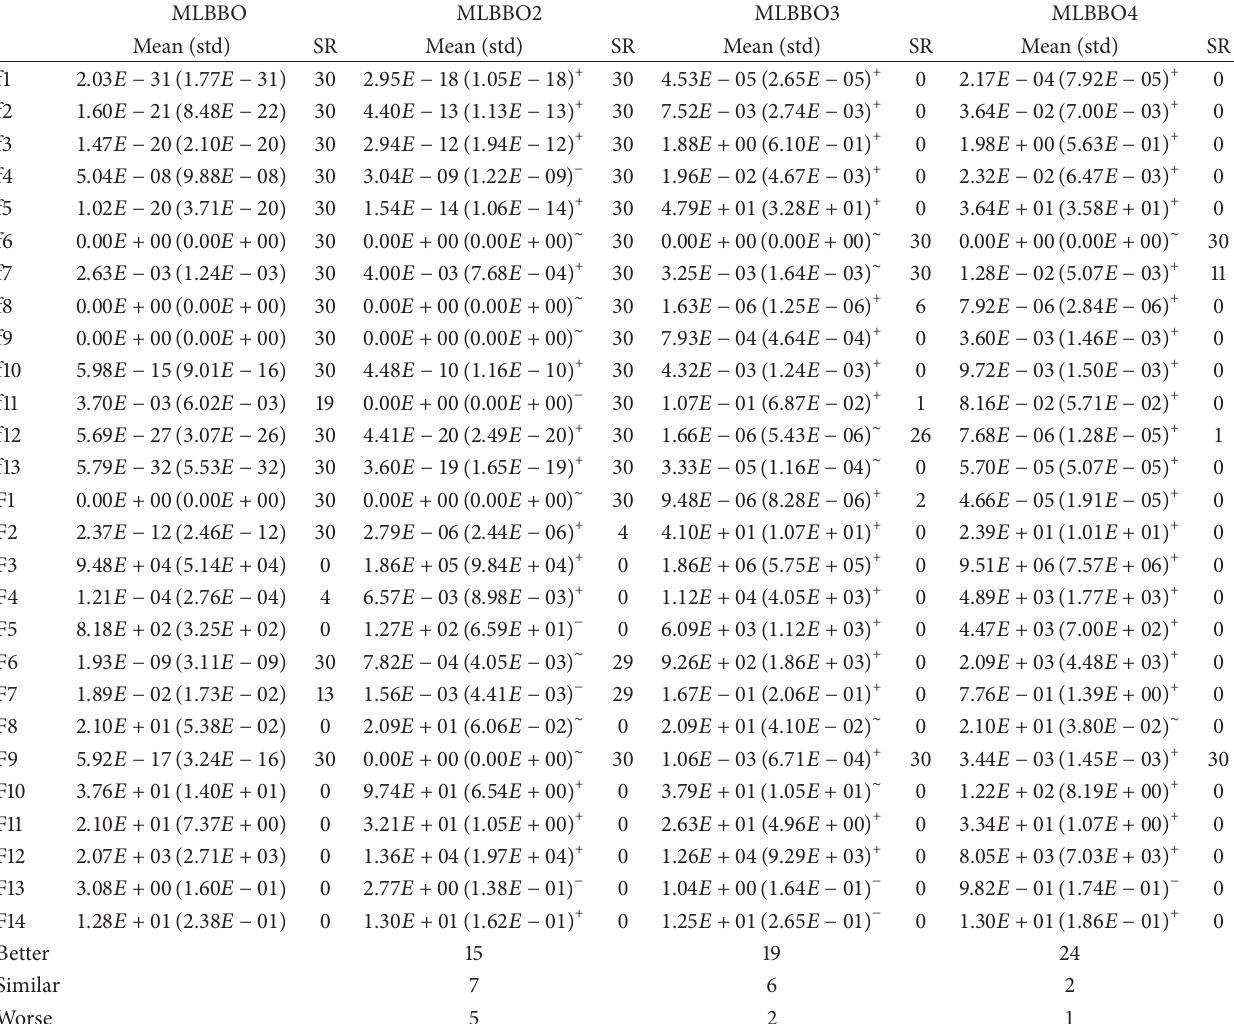
Table 7: Analysis of the performance of operators in